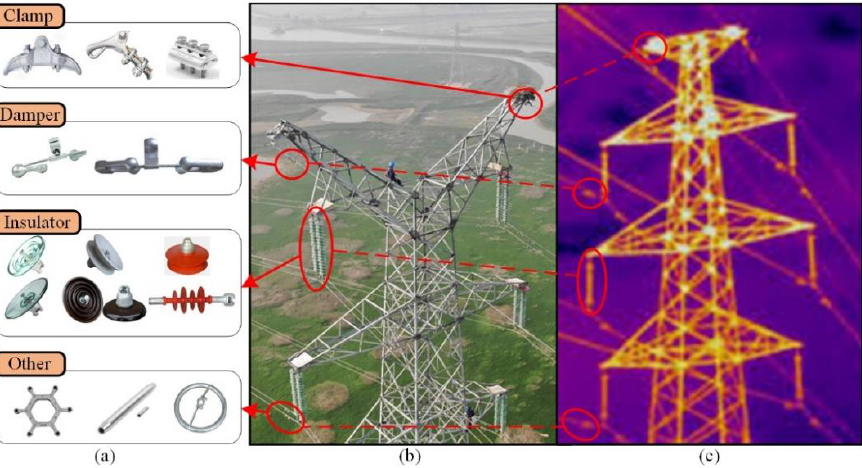
Figure 5. Schematic diagram of the collected data. ( a ) some of the fittings; ( b ) RGB image of the power tower; ( c ) depth map of the power tower.